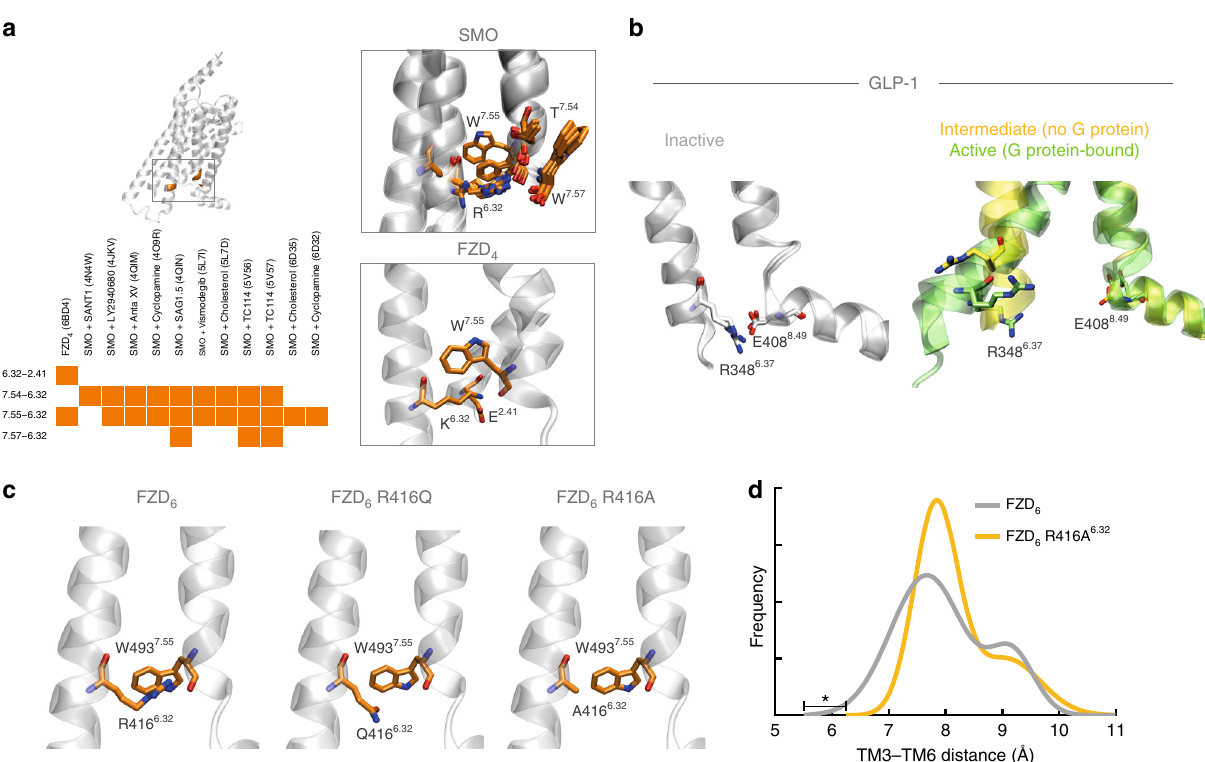
Fig. 2 Interactions between R/K 6.32 and helix 7 allow for a molecular switch mechanism. a General receptor and magni fi ed view centered on residue 6.32 of a structural overlay of all available SMO and FZD 4 crystal structures (PDB IDs SMO: 5L7D, 5L7I, 5V56, 5V57, 4O9R, 4N4W, 4JKV, 4QIM, 4QIN, 6D32, 6D35; FZD 4 : 6BD4). Residue 6.32 and its interacting residues are shown in orange stick representation. The bottom, left inset shows contact fi ngerprints for all interactions measured using the Protein Contact Atlas between residue 6.32 and residues in TM7 and TM2 (an orange box indicates that the contact is present in that structure, a white box indicates absence of the contact). All structures present inactive structures in the absence of heterotrimeric G protein. b Representation of the equivalent receptor region in the previous panel in GLP-1 receptors. Inactive (PDB IDs: 5VEW and 5VEX, gray), intermediate (PDB ID: 5NX2, orange), and active/G protein-bound (PDB IDs: 5VAI and 6B3J, green) structures are shown. The proposed TM6 – TM7/ H8 switch residues are shown as sticks. c Left panel: computational model of FZD 6 based on the SMO crystal structure (PDB ID: 4JKV). R416 6.32 on TM6 and W493 7.55 on TM7 are highlighted in orange. Middle panel: representation of the naturally occurring cancer mutant FZD 6 R416Q 6.32 . Right panel: representation of the experimental R416A 6.32 mutant. d Analysis of the frequency of the of TM3-TM6 (W 3.50 – G 6.34 ) distance distributions over MD simulation time for FZD 6 and FZD 6 R416A 6.32 . Threshold values are compared using unpaired t test; n = 3 (FZD 6 ) n = 4 (FZD 6 R416A 6.32 ); P = 0.0281; t = 3.060; df = 5. * P < 0.05 (two-tailed t